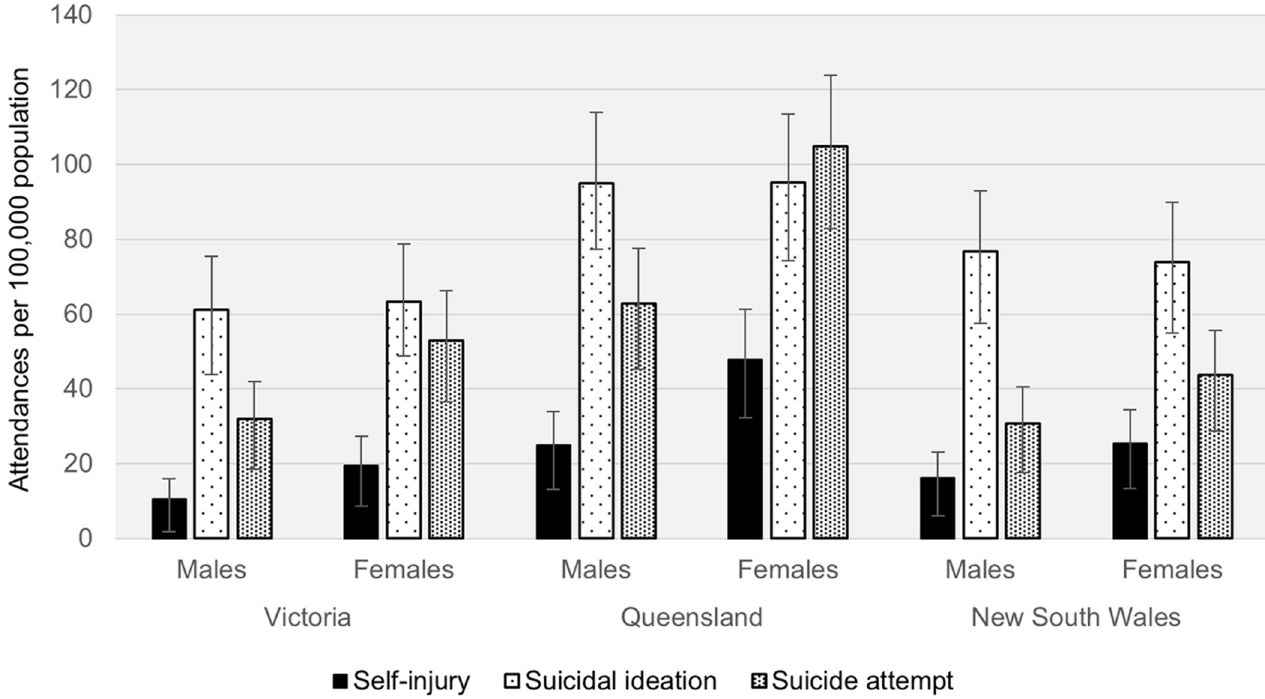
Fig 2. Types of self-harm related ambulance attendances per 100,000 population in Victoria, Queensland and New South Wales, 2016 snapshot months (Mar, Jun, Sep, Dec). Error bars represent the binomial proportion confidence interval based on Clopper-Pearson/exact interval.